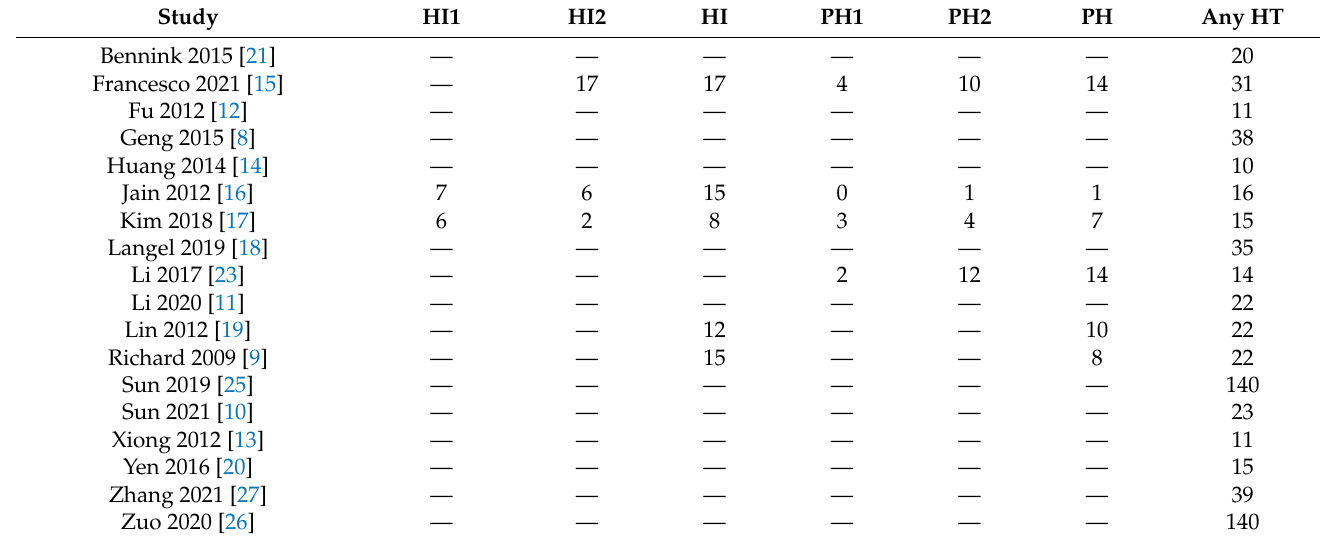
Table 2. Number of HT subtypes classified according to the ECASS II.